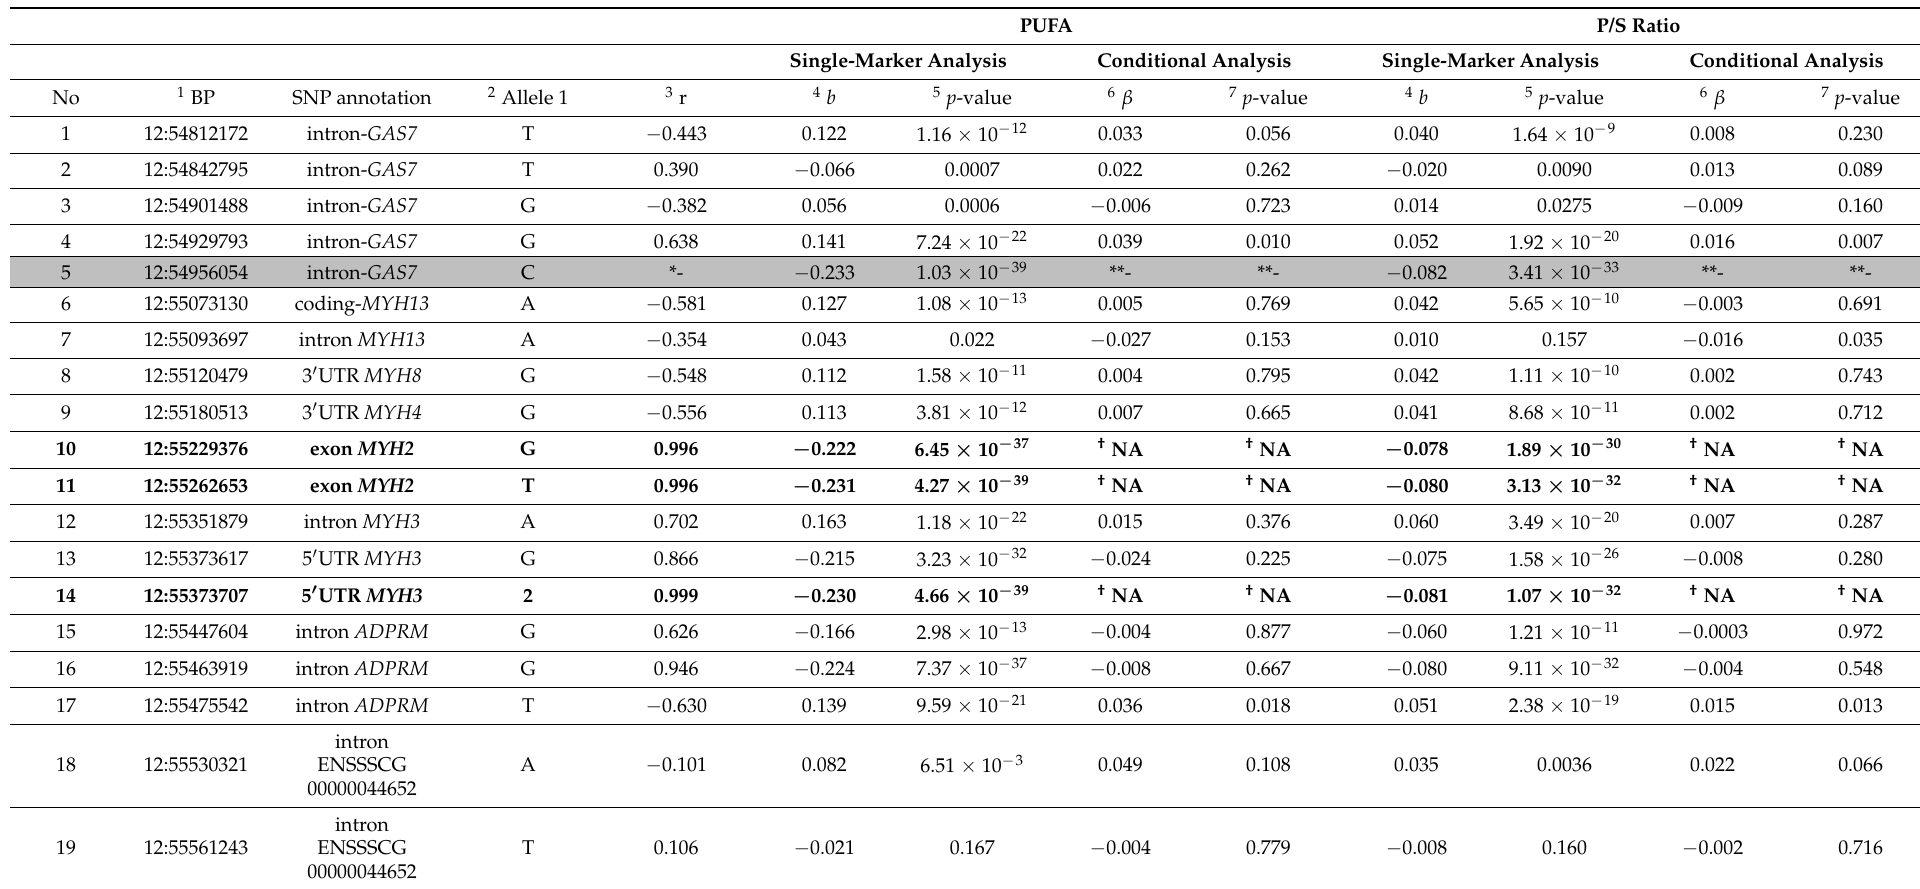
Table 5. Results of conditional association analyses for PUFA and P/S ratio using SNP markers in the 749.1 kb critical region in SSC12. PUFA P/S Ratio Single-Marker Analysis Conditional Analysis Single-Marker Analysis Conditional